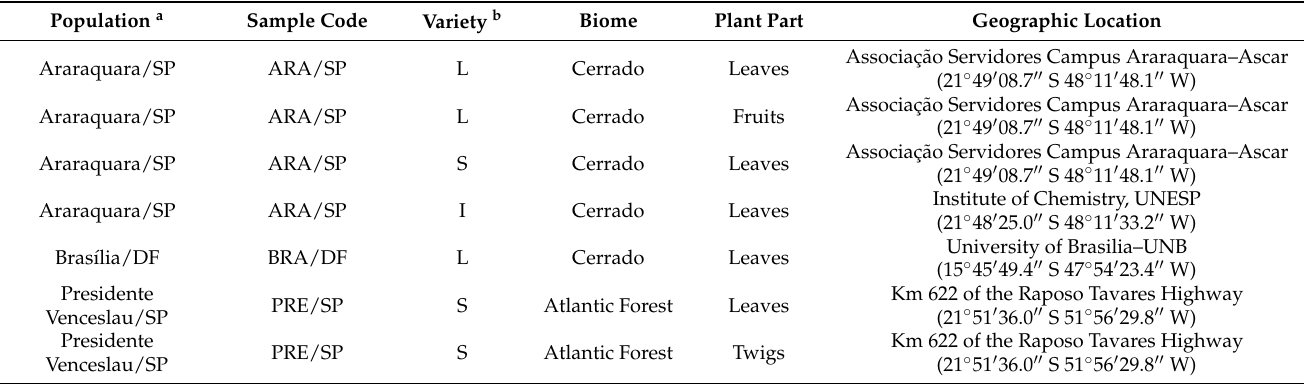
Table 1. Samples of C. sylvestris from different Brazilian